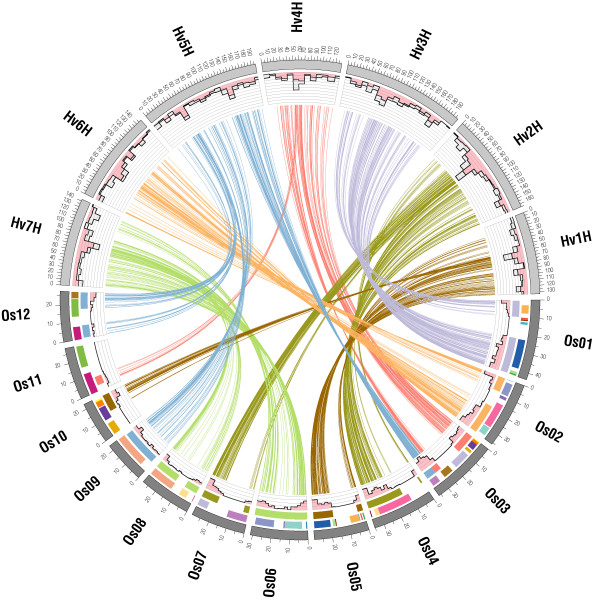
Barley – rice synteny. Best sequence similarities are displayed for syntenic barley ESTs placed on the seven barley chromosomes (Hv1H – Hv7H) to the rice genome (Os01 – Os12) by connecting lines. Histograms at barley chromosomes show the total number of markers and the proportion of those markers with synteny to rice in grey and red, respectively (10 cM intervals, scale: 0 – 50, scale spacing 5). Outer bars at the rice chromosomes show duplicated segment pairs within the rice genome (see Figure 1), inner bars indicate syntenic regions to the barley genetic map. The 12 histograms along the rice chromosomes show the ratio to the total number of annotated rice genes, which were syntenic to barley (scale: 0 – 0.08, scale spacing 0.02). Positions for rice are in Mb and for barley in cM.